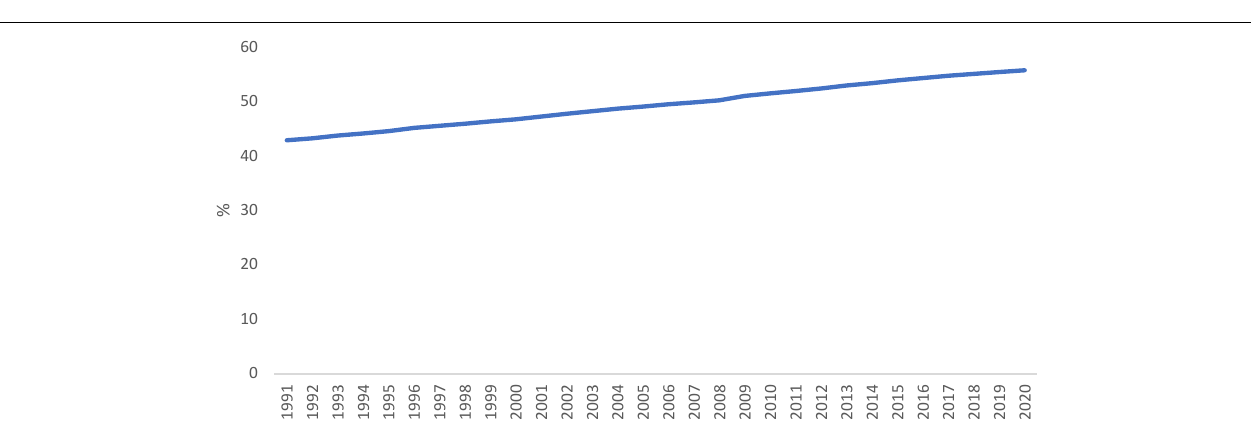
FIGURE 2 | Employment in service (% of total employment). Source: World Bank